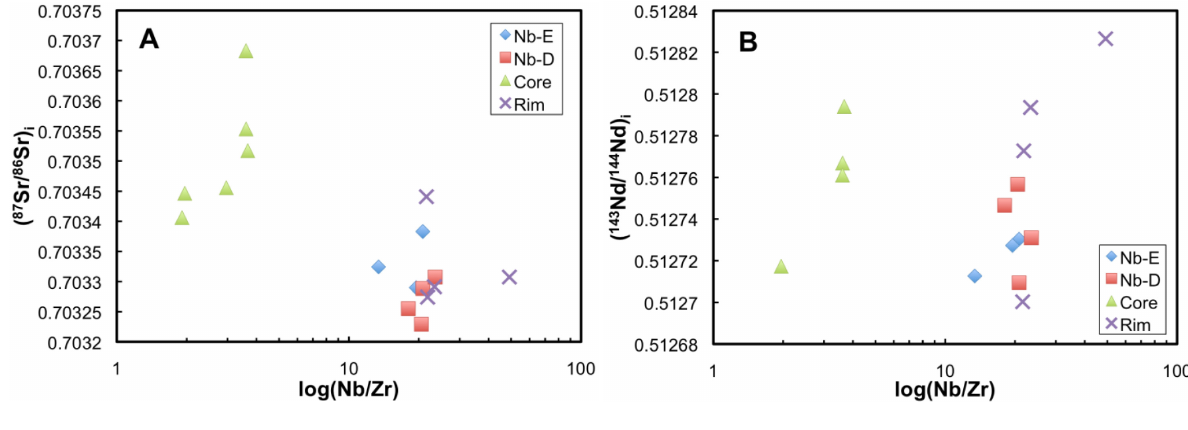
Figure 14. ( A ) Diagram of 87 Sr/ 86 Sr vs. Nb/Zr illustrating the different groups of perovskite; and ( B ) Plot of 143 Nd/ 144 Nd vs. Nb/Zr for the different perovskite